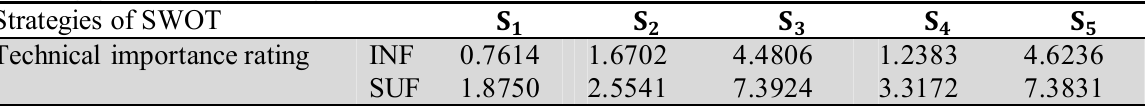
Ranking generated by ER algorithm Strategies of SWOT Technical importance rating